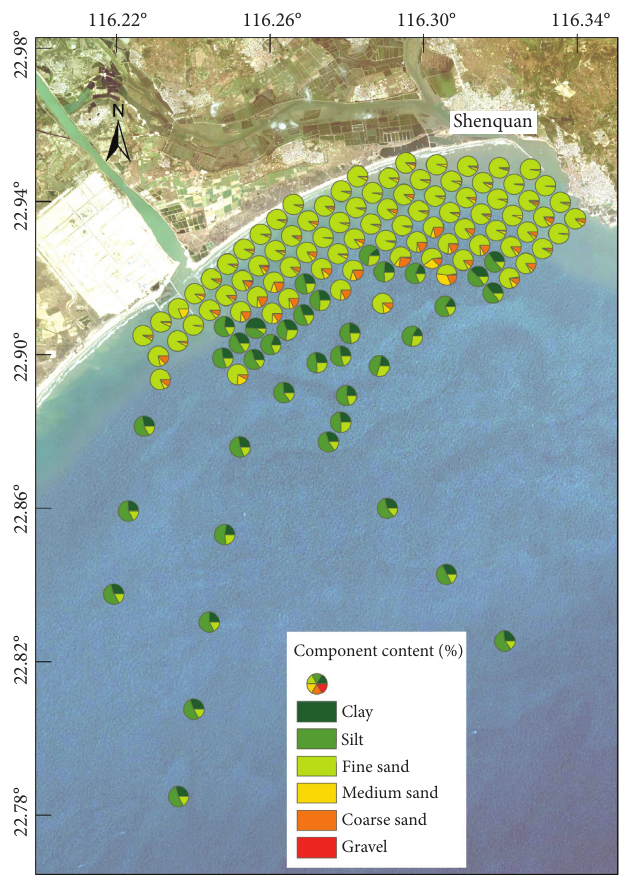
Figure 10: The sediment component content at the corresponding